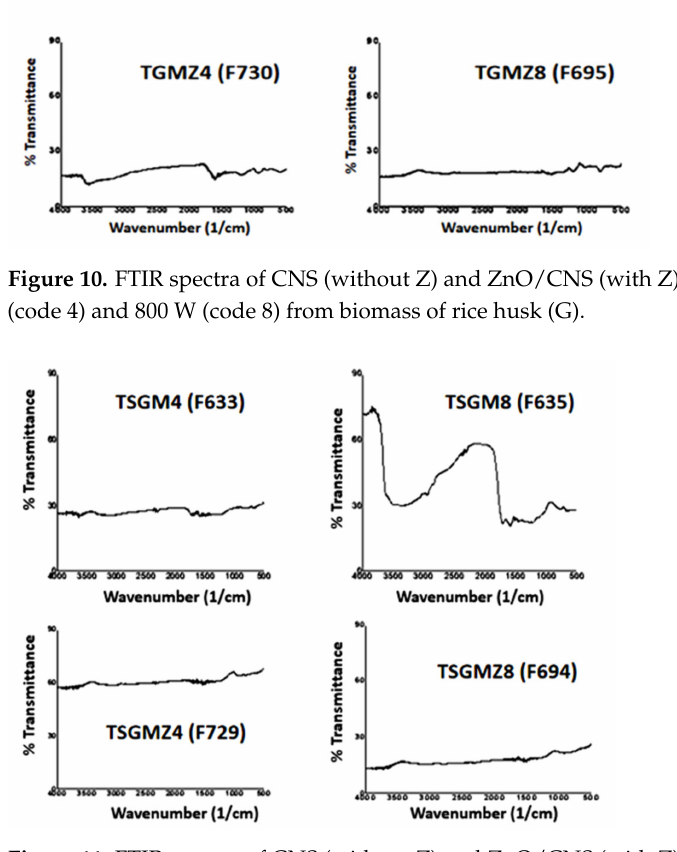
Figure 11. FTIR spectra of CNS (without Z) and ZnO/CNS (with Z) which were prepared at 400 W (code 4) and 800 W (code 8) from biomass of sawdust